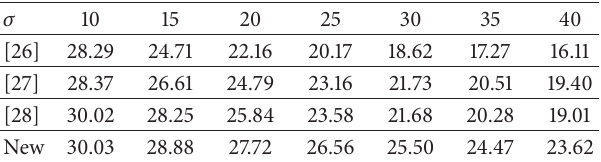
Table 4: PSNR of different algorithms with different Speckle noise levels for Salesman video